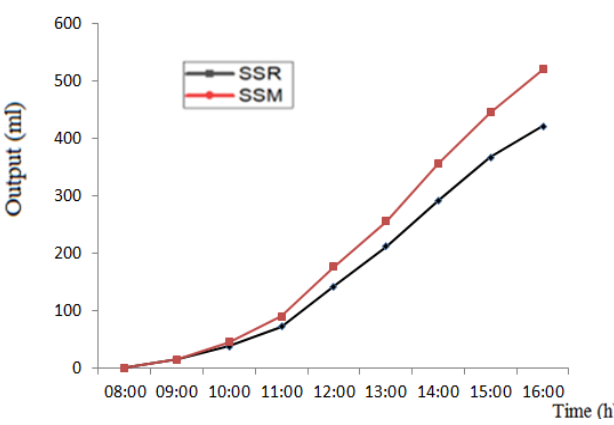
Figure 7 . Accumulation output of pure